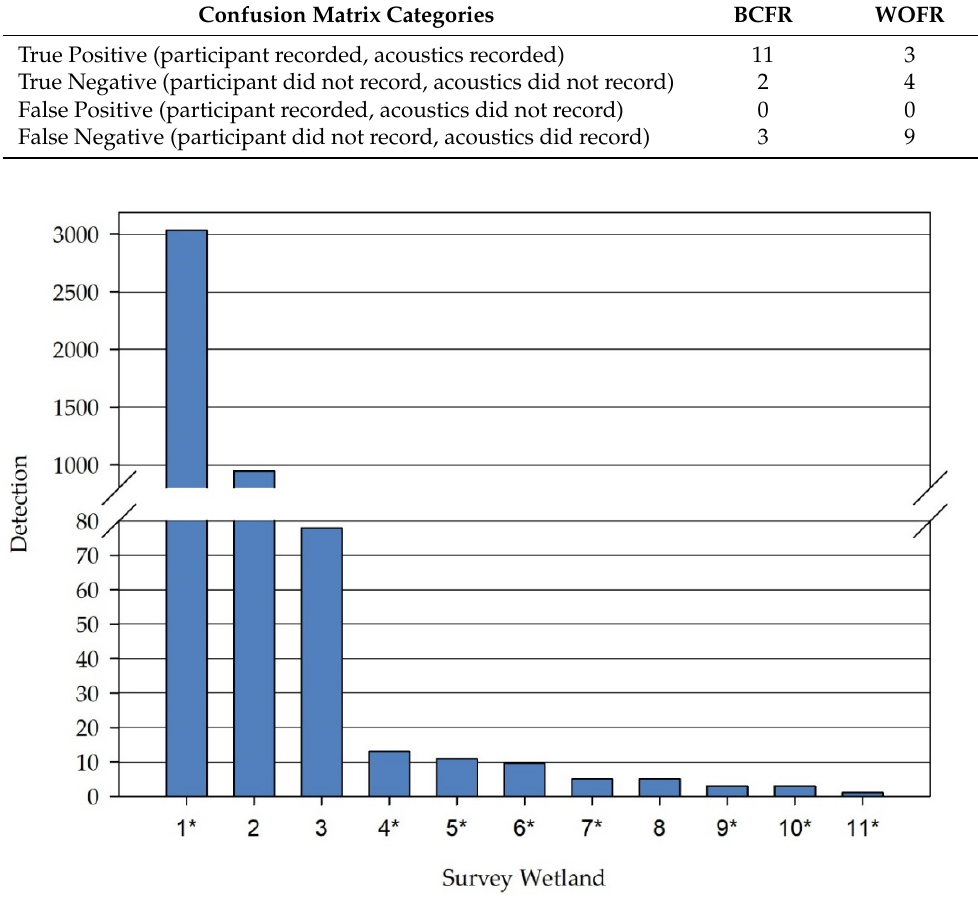
7 of 15 Figure 2. Map depicting the number of amphibian species observed at Calgary wetlands from 2017 to 2019. Species were not necessarily observed in the same year. Map includes incidental ob- servations submitted in addition to observations at survey sites. The resulting amphibian data set enabled occupancy modeling to identify important